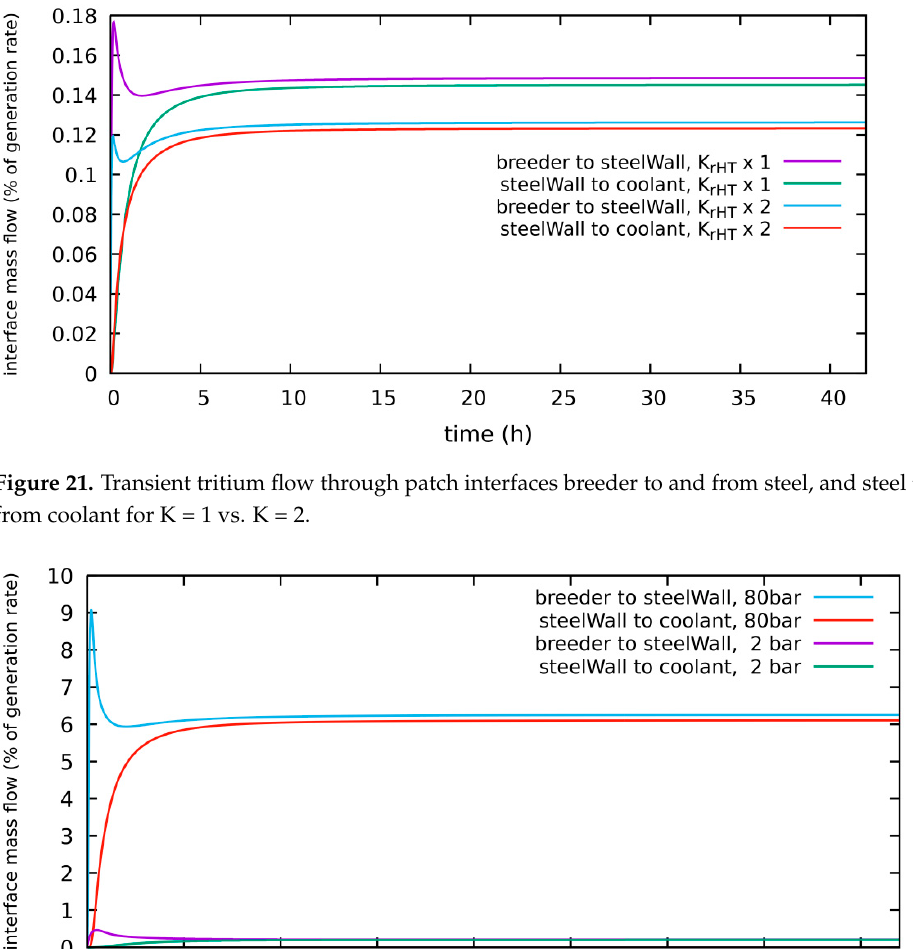
Figure 21. Transient tritium flow through patch interfaces breeder to and from steel, and steel to and from coolant for K = 1 vs. K = 2.